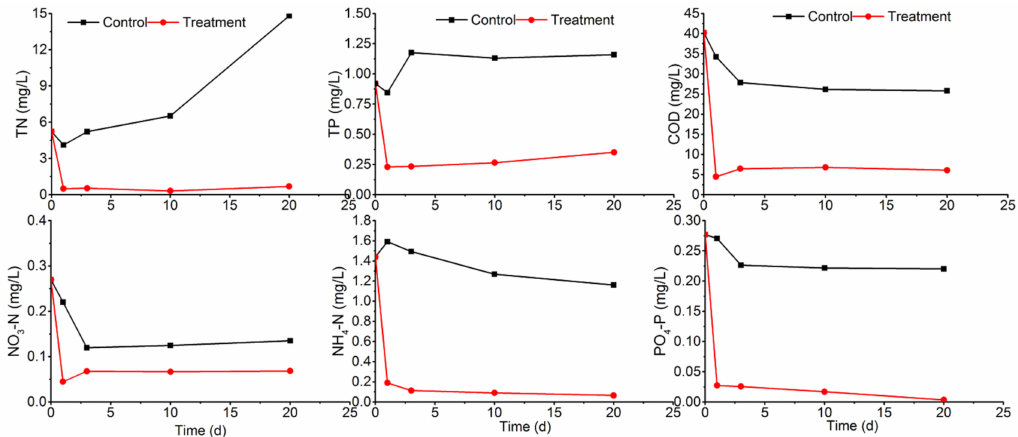
− − N, NO − − N, and PO 3 − 3 2